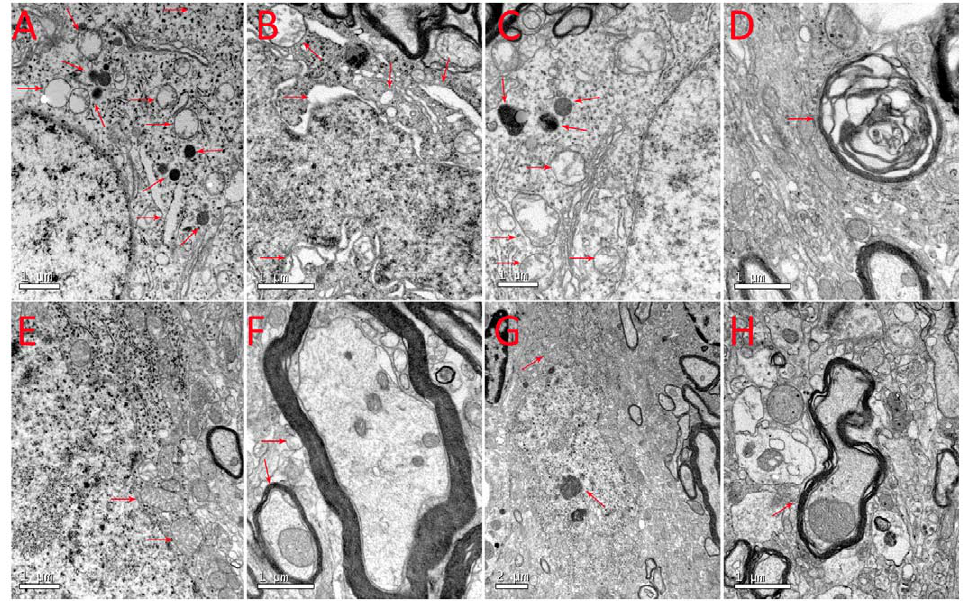
Figure 5. Ultrastructural changes in SNc. (A): mitochondrial swelling, mitochondrial crest fracture, mitochondrial vacuolar degeneration, dilated and broken rough endoplasmic reticula, liberation of ribosomes from the rough endoplasmic reticula and the increased formation of lysosomes; (B): mitochondrial swelling, mitochondrial crest fracture, dilated and broken rough endoplasmic reticula, perinuclear space augmentation; (C): mitochondrial swelling, mitochondrial crest fracture, the increased formation of secondary lysosome formation;(D): degeneration of the medullary sheathes; (E, G): normal mitochondria, rough endoplasmic reticulum and ribosomes in the SNc neurons of the Veh-group and Eda-group rats; (F, H): normal medullary sheathes from the Veh-group and Eda-group rats (7 rats from ROT-group, 6 rats from Eda-group and 4 rats from